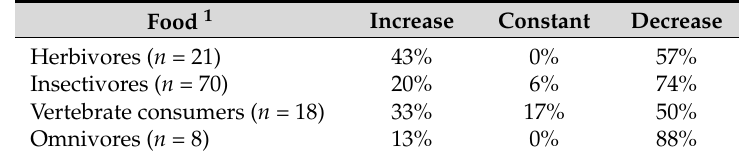
Table 3. Long-term development of breeding bird species in relation to their food sources at “Lampertheimer Altrhein” (from 1974–1979 to 2017).